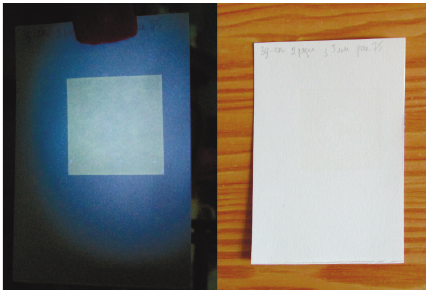
Figure 3: Screen printed impressions of the developed ink composi- tions under UV light ( 𝜆 = 330 nm) and daylight, respectively. [ZnO] = 0.15% and [PVP] = 12%.